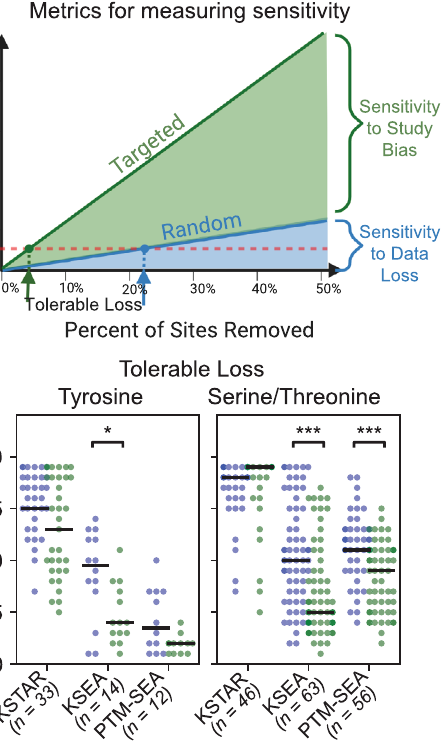
Fig. 4 | Comparing sensitivity to data loss and study bias. a Metrics de fi ned to measure sensitivity to data loss and study bias. For a kinase in a prediction that starts as signi fi cant, we select data to be removed based on completely random selection or semirandom selection where high study bias sites are removed fi